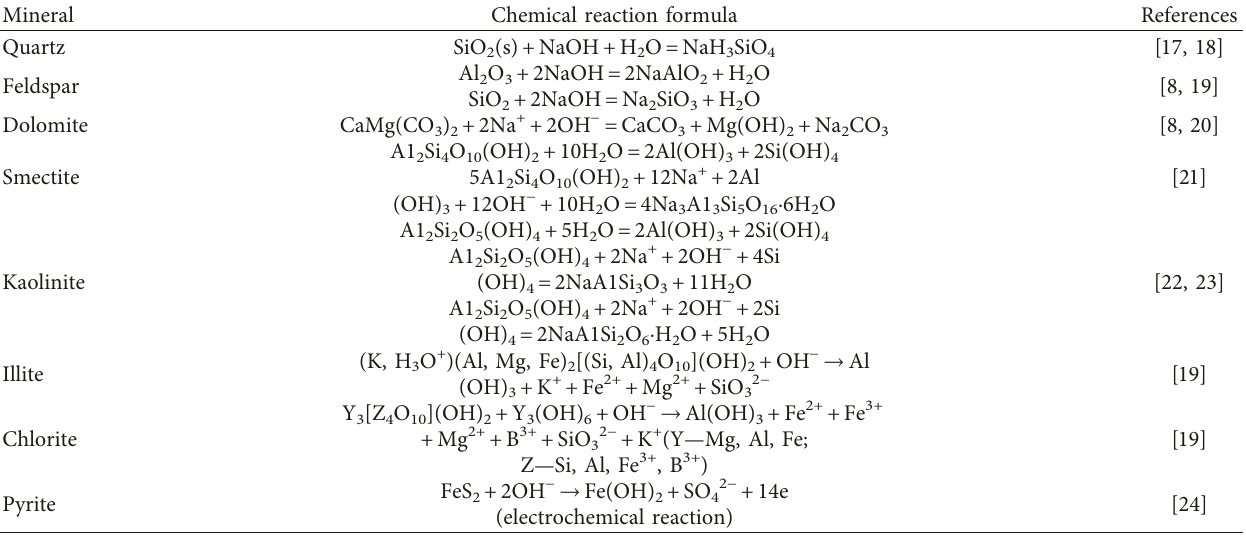
Table 3: Chemical reaction formula of minerals and sodium hydroxide solution.